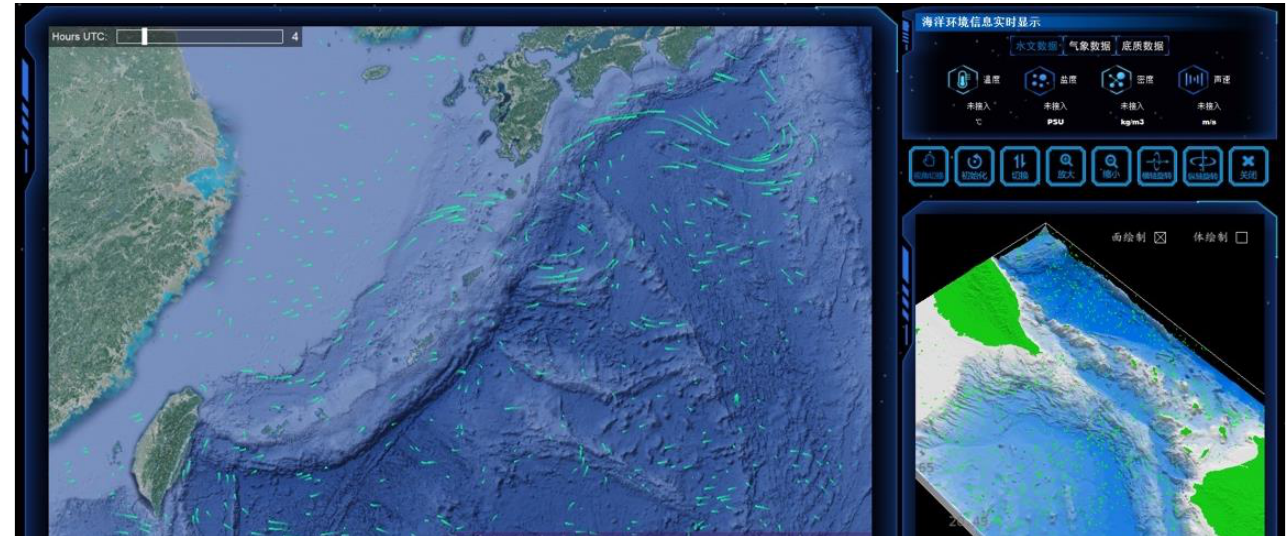
Table 1. Rendering Results Comparison. Rendering Method